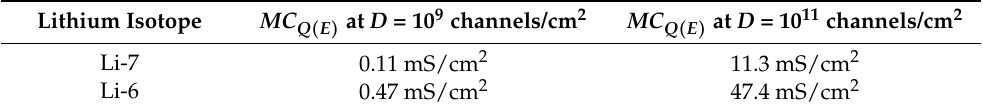
Table 14. The table shows that extracellular lithium isotopes can have a range of quantum membrane conductance from the value at D = 10 9 channels/cm 2 to the value at D = 10 11 channels/cm 2 according to the setting values in graph (d) of Figure 6.